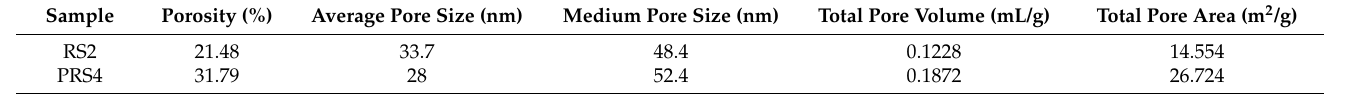
Table 6. SSA of porous reconstructed steel slag with different content of SiC.